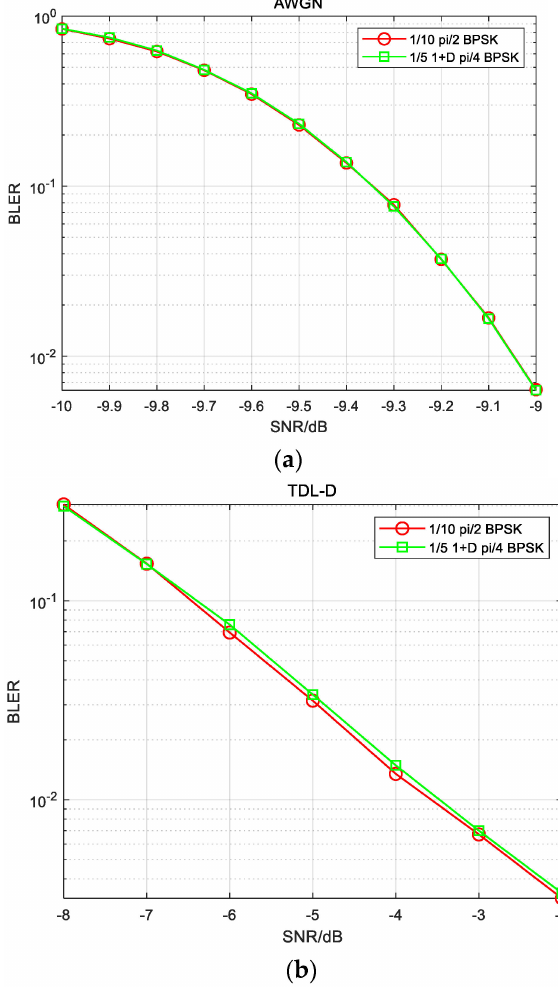
Figure 6. BLER comparison under AWGN. ( a ) AWGN; ( b )